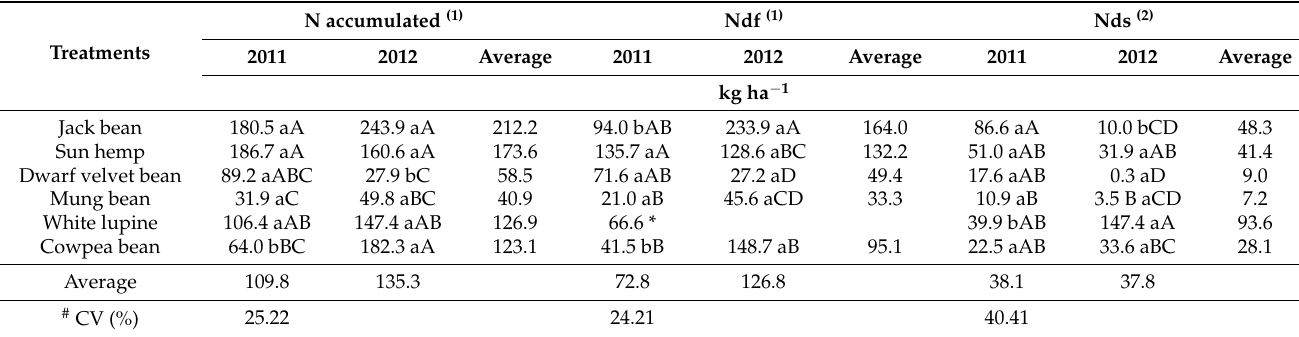
Figure 3. Biological nitrogen fixation (BNF) of legumes at 40 days after sowing (DAS) and 100 DAS in intercropping with cherry tomato in ( A ) 2011 and ( B ) 2012. The means followed by the same lowercase letter in the lines do not differ by the Tukey–Kramer test ( p < 0.10). (2) Statistics on transformed data for log(x). Table 5. Total accumulated nitrogen and the N accumulated derived from biological nitrogen fixation (Ndf) and nitrogen derived from soil (Nds) at 100 DAS.